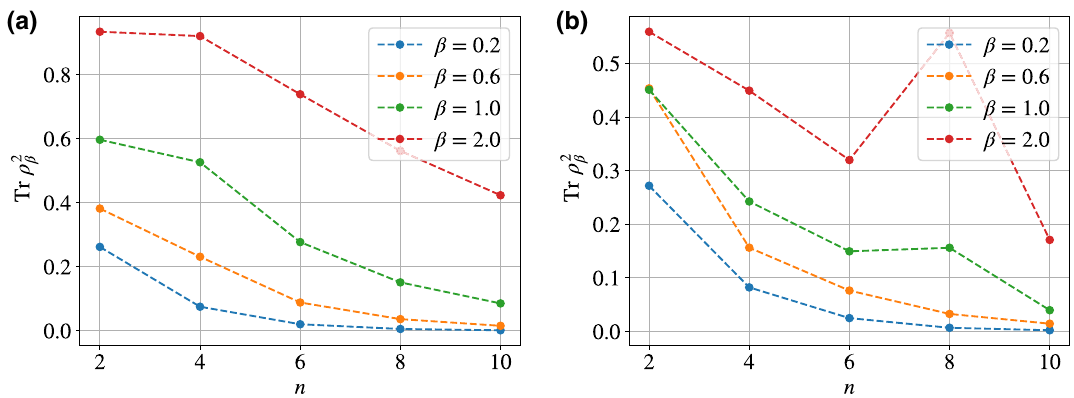
FIG. 5. The purity, Tr ρ 2 β , as a function of the system size, n , for (a) the XXZ-Heisenberg model (with J = 0.5, (cid:13) = 0.7, and closed boundary conditions) and (b) a random Hamiltonian with all-to-all connectivity (the XYZ-Heisenberg model with random couplings between all qubits and a random field on each qubit). Note that for (b), we use a different random initialization for each n . The jump observed at n = 8 and β = 2 is an outlier.